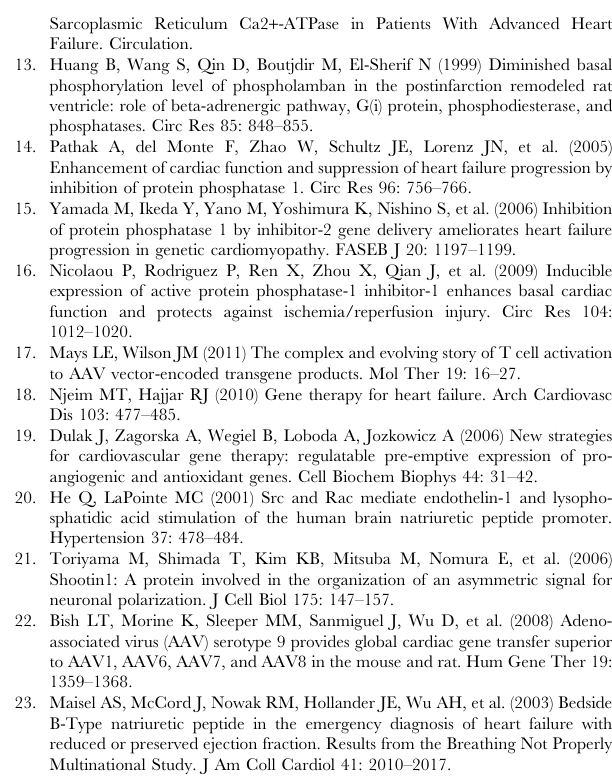
Figure S2 A : Body weight, heart weight, and heart/lung weight ratio in 4 month-old MLP knockout mice and age-matched wild- type littermates. B : Immunoblottings of PP1 catalytic subunit isoforms, a , b / d , and c in LV homogenates. a -Actininn was used as protein loading control. Left graphs indicates quantitative immunoblot analysis of PP1 a , b / d , and c in MLP knockout mice and age-matched wild type littermates. Figure S3 BNP expression analysis by using real-time RT-PCR in 4–5 month-old MLP knockout mice and age-matched wild type littermate hearts. ‘‘*’’ indicates p , 0.05 vs. wild type littermates.